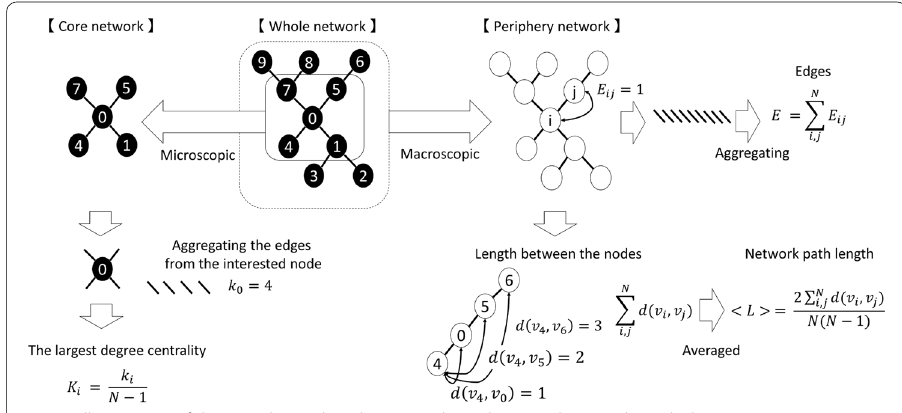
Fig. 4 Illustrations of the set relationships between the indexes and networks with the